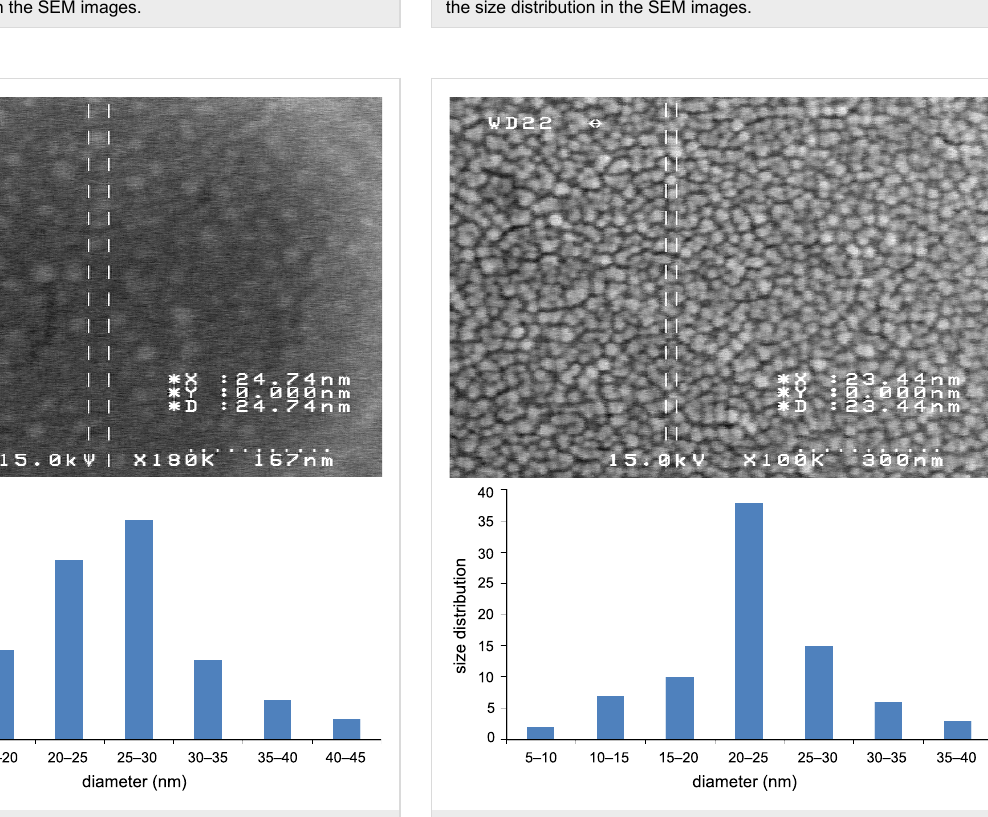
Figure 6: SEM micrograph of compound 4 and histogram indicating the size distribution in the SEM